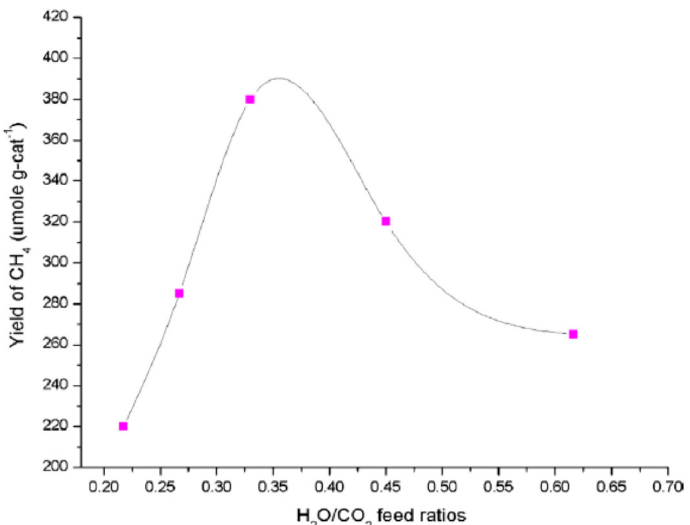
Figure 10. Effect of H 2 O/CO 2 ratio over CH 4 yield, reproduced with permission from reference [30]. Copyright Elsevier, 2013.